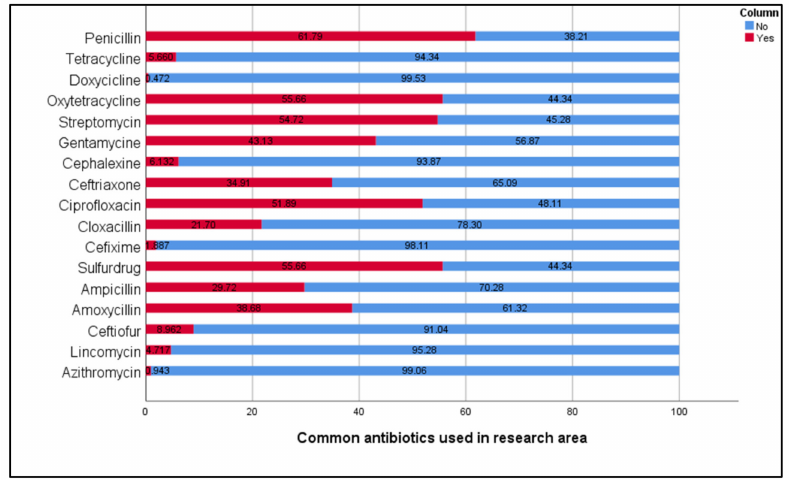
Figure 1. Common antimicrobials used on livestock in the study area